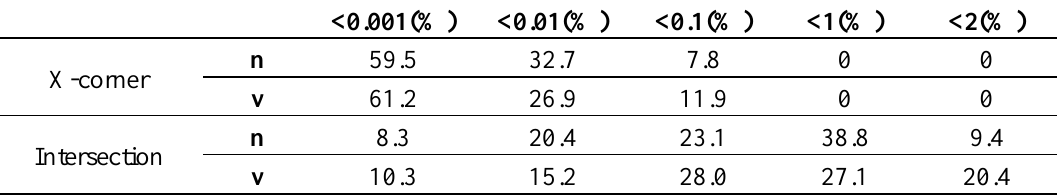
Table 5. Statistics of vectors fitted by X-corners and intersections,